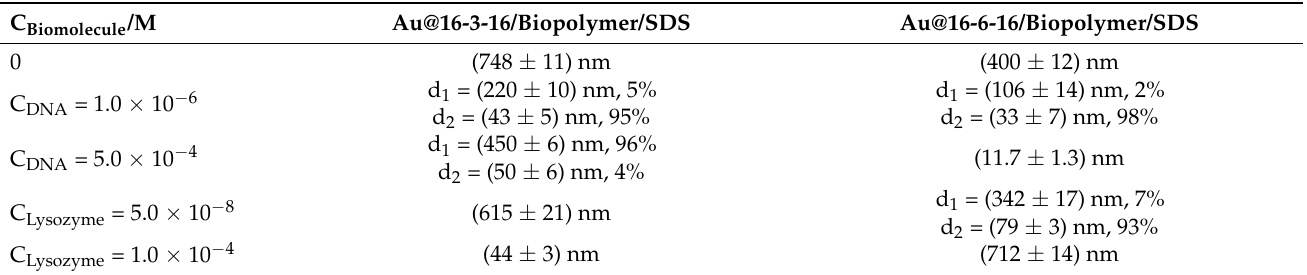
Table 4. Values of the hydrodynamic diameters of di ff erent Au@16-s-16 nanosystems in the presence of fi xed C SDS = 5.0 × 10 − 5 M concentration and biomolecules.